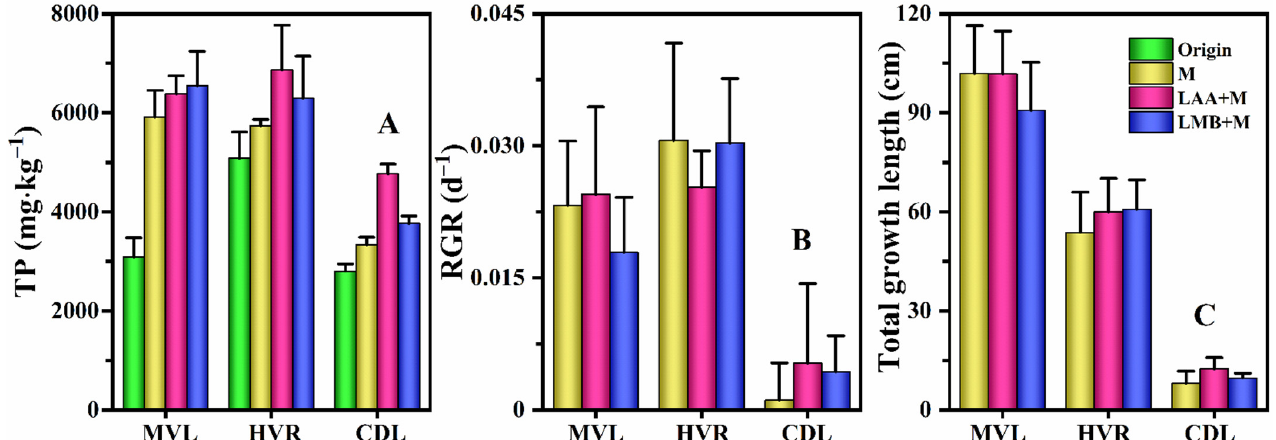
Figure 7. Macrophyte traits at the experiment. ( A ) indicates the change of TP content in different types of macrophytes. ( B , C ) represent the relative growth rate ( RGR ) and total growth length (length of macrophyte growth between the start and end of the experiment) of macrophytes in the experi- ments, respectively. MVL, HVR and CDL are Myriophyllum verticillatum L., Hydrilla verticillata (Linn. f.) royle and Ceratophyllum demersum L.,